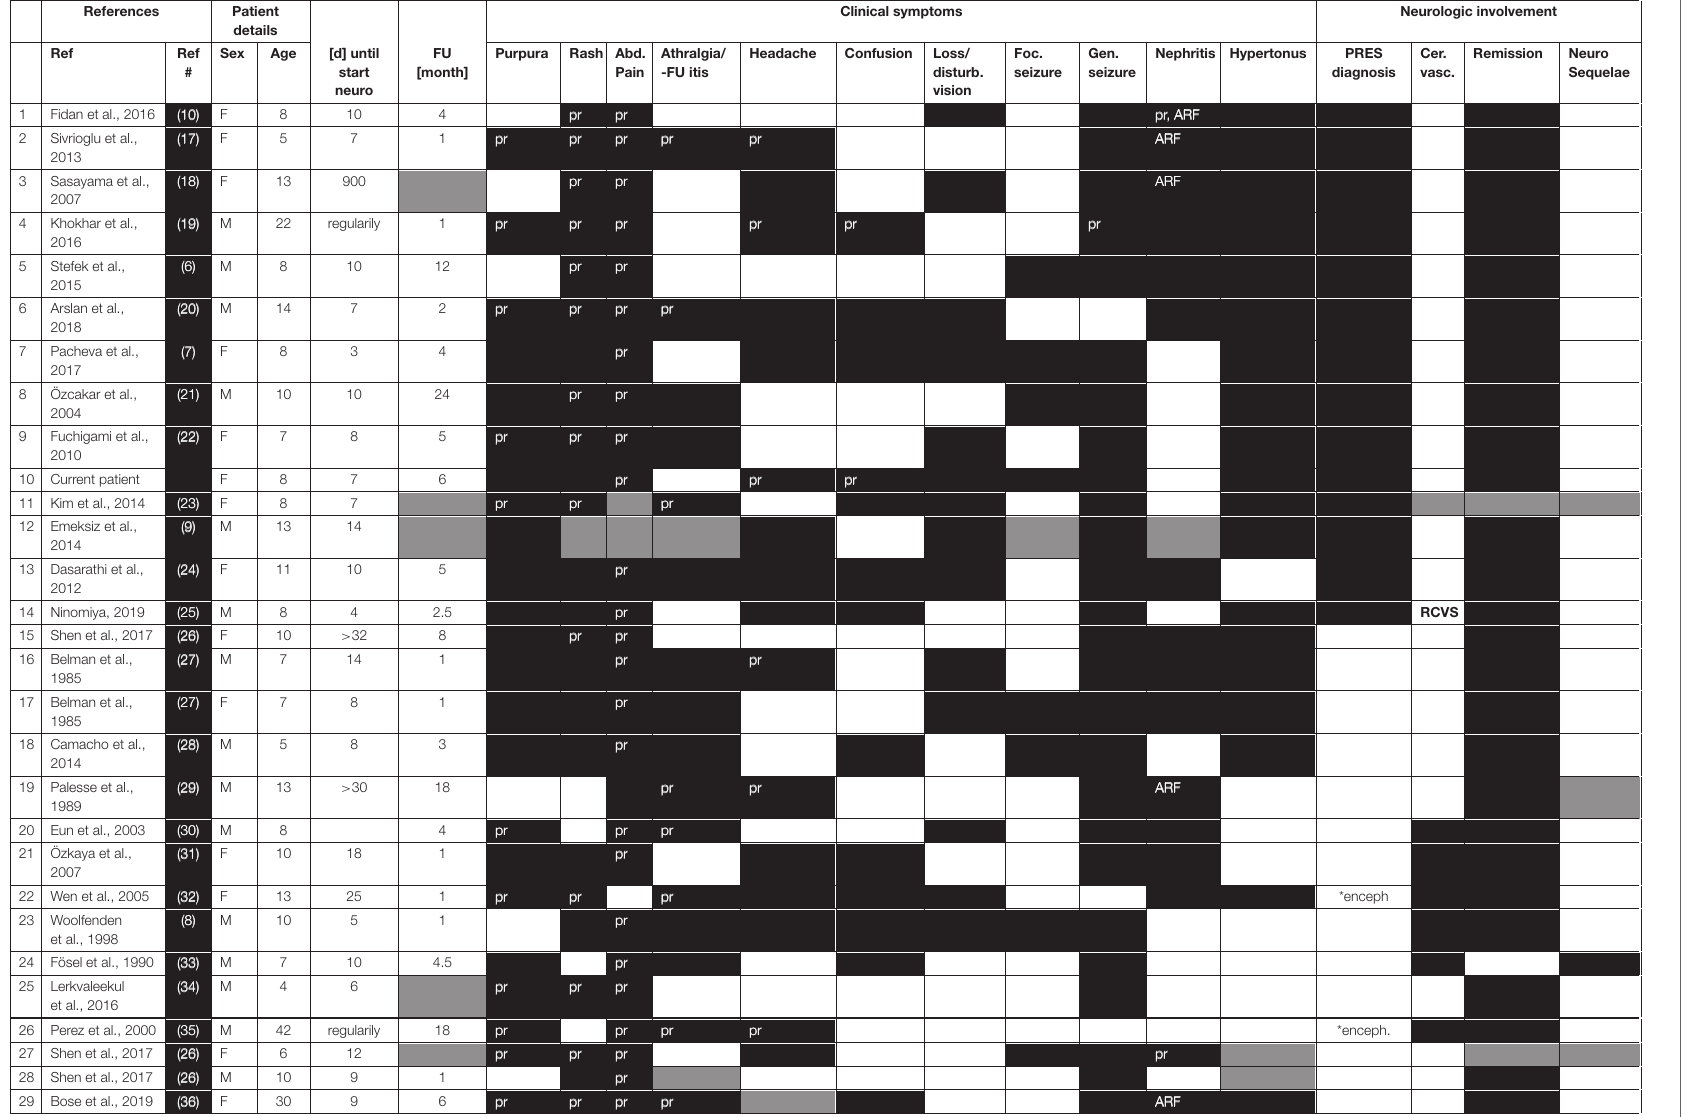
TABLE 1 | List of all 28 and our novel patients suffering from IgAV and neurological impairment.